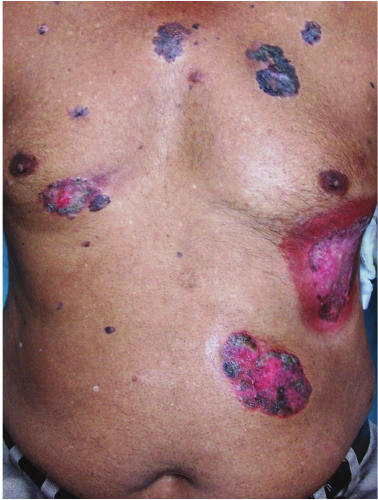
Figure 1: Multiple hyperpigmented plaques and erosions of irreg- ular shapes and sizes with and without scaling on the trunk.